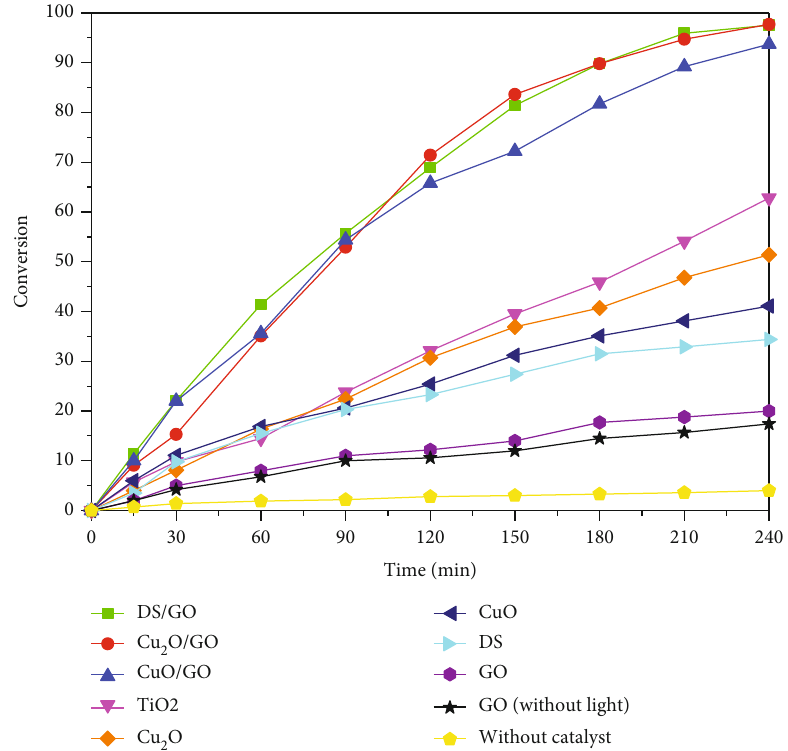
Figure 3: Photodegradation conversion of RhB as a function of irradiation time in the presence of di ff erent catalysts.